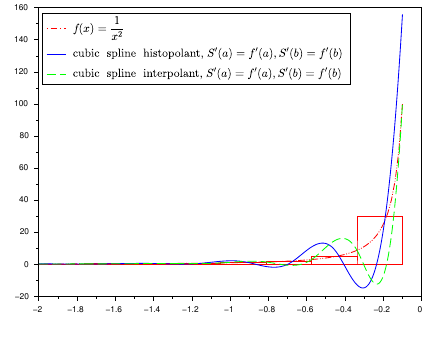
Figure 3. Cubic spline histopolant and interpolant for n = 8